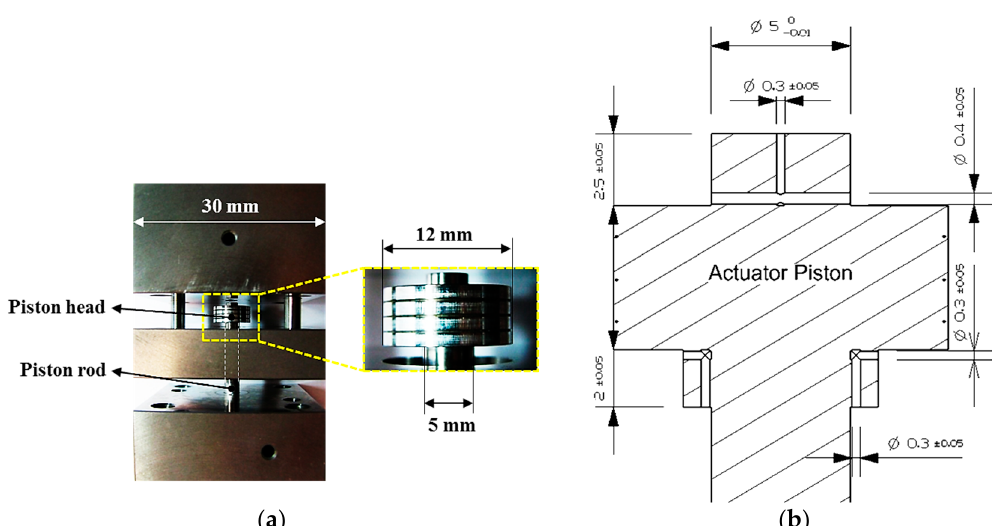
Figure 4. Details of an EH-CEVA: ( a ) proportional hydraulic valve module; ( b ) hydraulic power pack module.